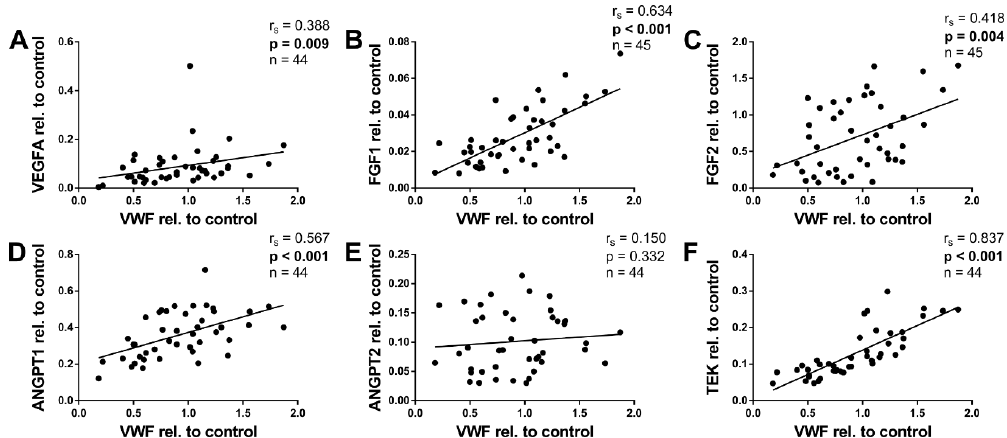
Figure 5. Association of angiogenic gene expression in pediatric WAT with VWF expression. Total RNA was isolated, reverse transcribed, and subjected to qPCR analysis using specific primer pairs as indicated. Respective gene expression was calculated as described in Methods. ( A – D ) VEGFA, FGF1, FGF2, and ANGPT1 correlated positively with VWF. ( E ) There was no significant correlation between ANGPT2 and VWF. ( F ) TEK, in turn, showed the strongest correlation with VWF. Spearman correlation coefficient r s and p value, as well as number of subjects, are given in each scatter plot. Significant p values ( p < 0.05) are indicated in bold. Trend lines were calculated as linear regressions.